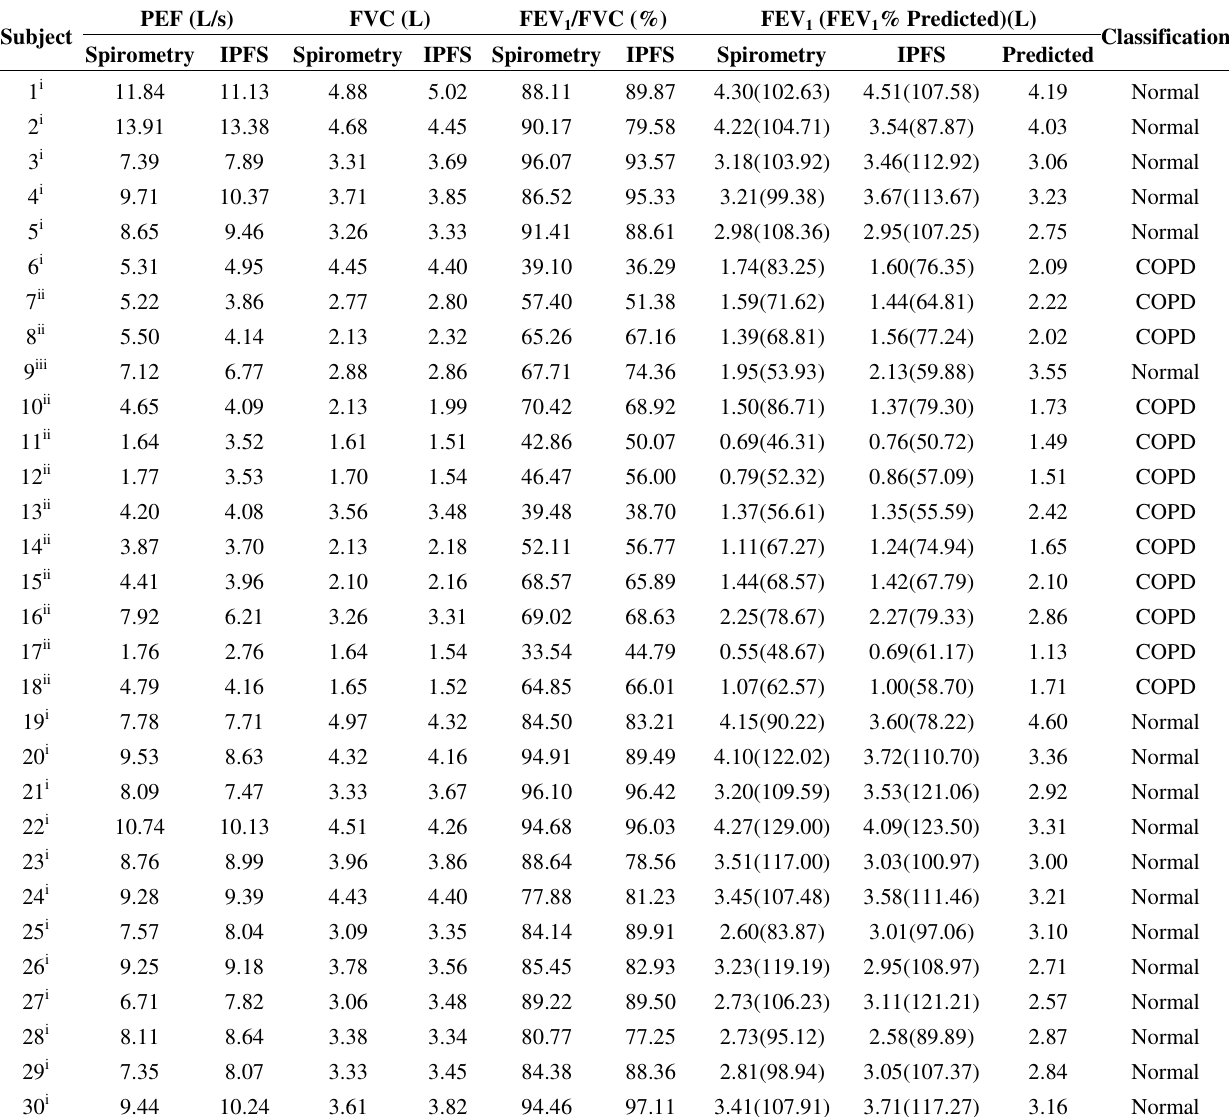
Table 2. Result of PFT indices for normal group and COPD